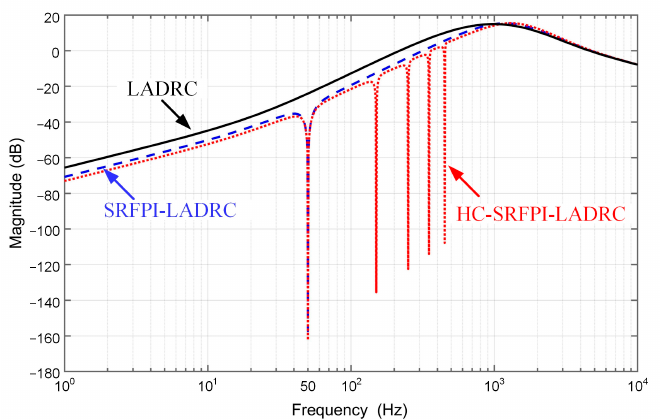
Figure 12. Bode magnitude plots of transfer function G drej ( s ) with different control strategies.